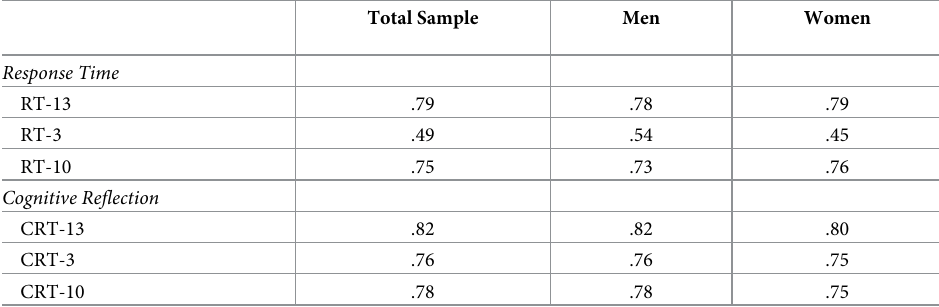
Table 6. Internal consistency reliability of response time and CR